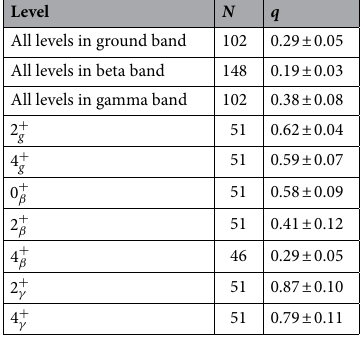
Table 1. q values, chaoticity parameter, for different levels of rotational bands determined via Eq. (6) and experimental data. N is the number of spacing in each sequence, which is from 51 nuclei. Sequences are constructed of experimental